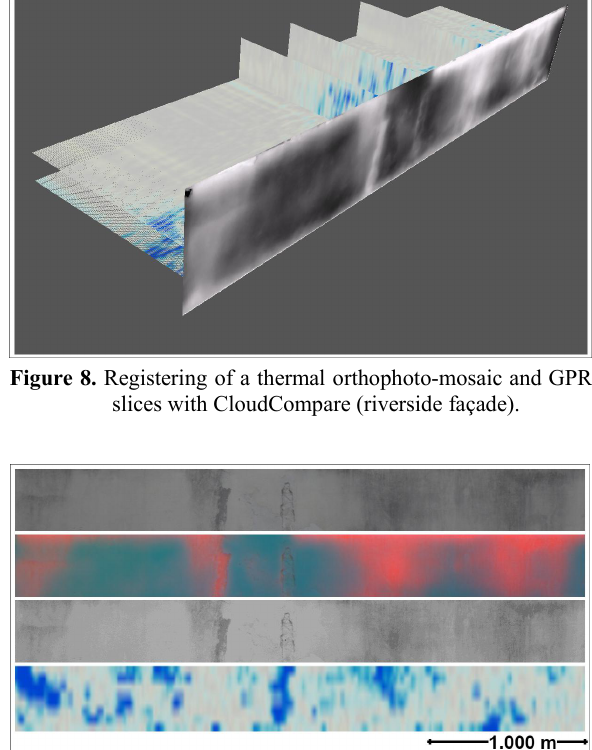
Figure 9. Interdisciplinary interpretation of multiband results (from top to bottom): orthophoto-mosaic, false color TIR-NIR-red composite photo-mosaic, map of surface alterations, and GPR slice parallel to the wall at 6 cm depth (riverside façade).